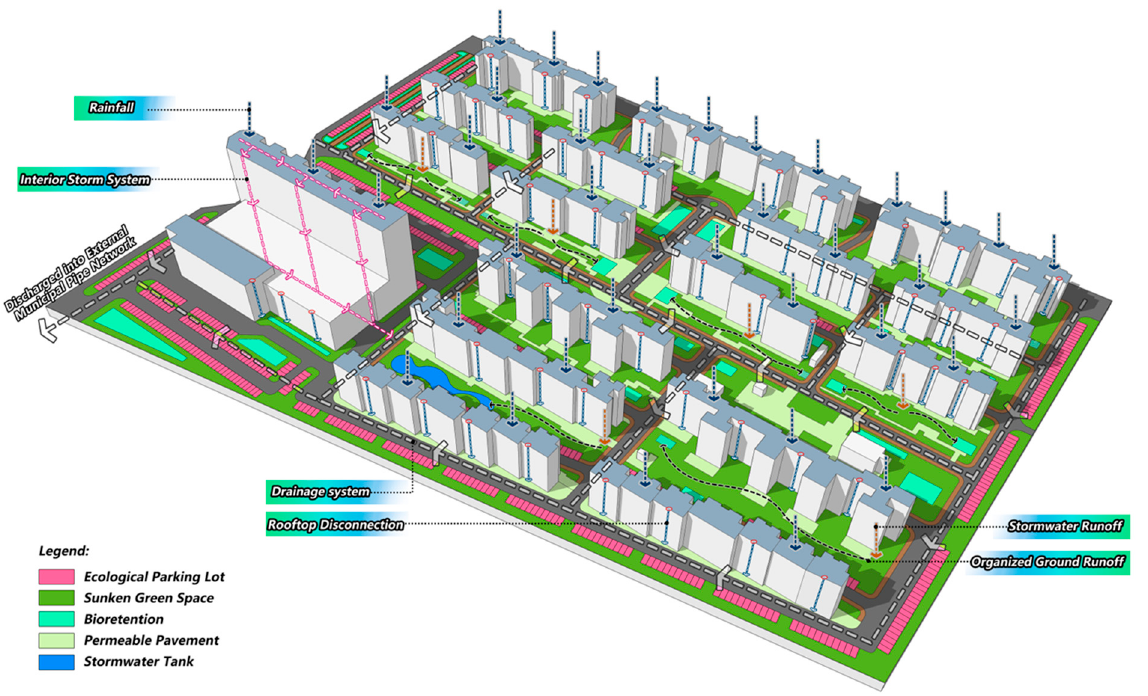
Figure 6. Community renovation under sponge city concept in Beijing, China.